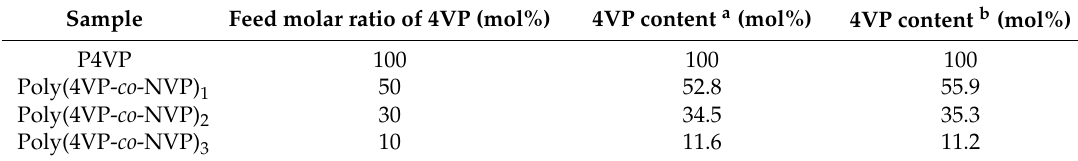
Table 1. Reaction parameter for the copolymerization of 4VP (M 1 ) and NVP (M 2 ) and copolymer